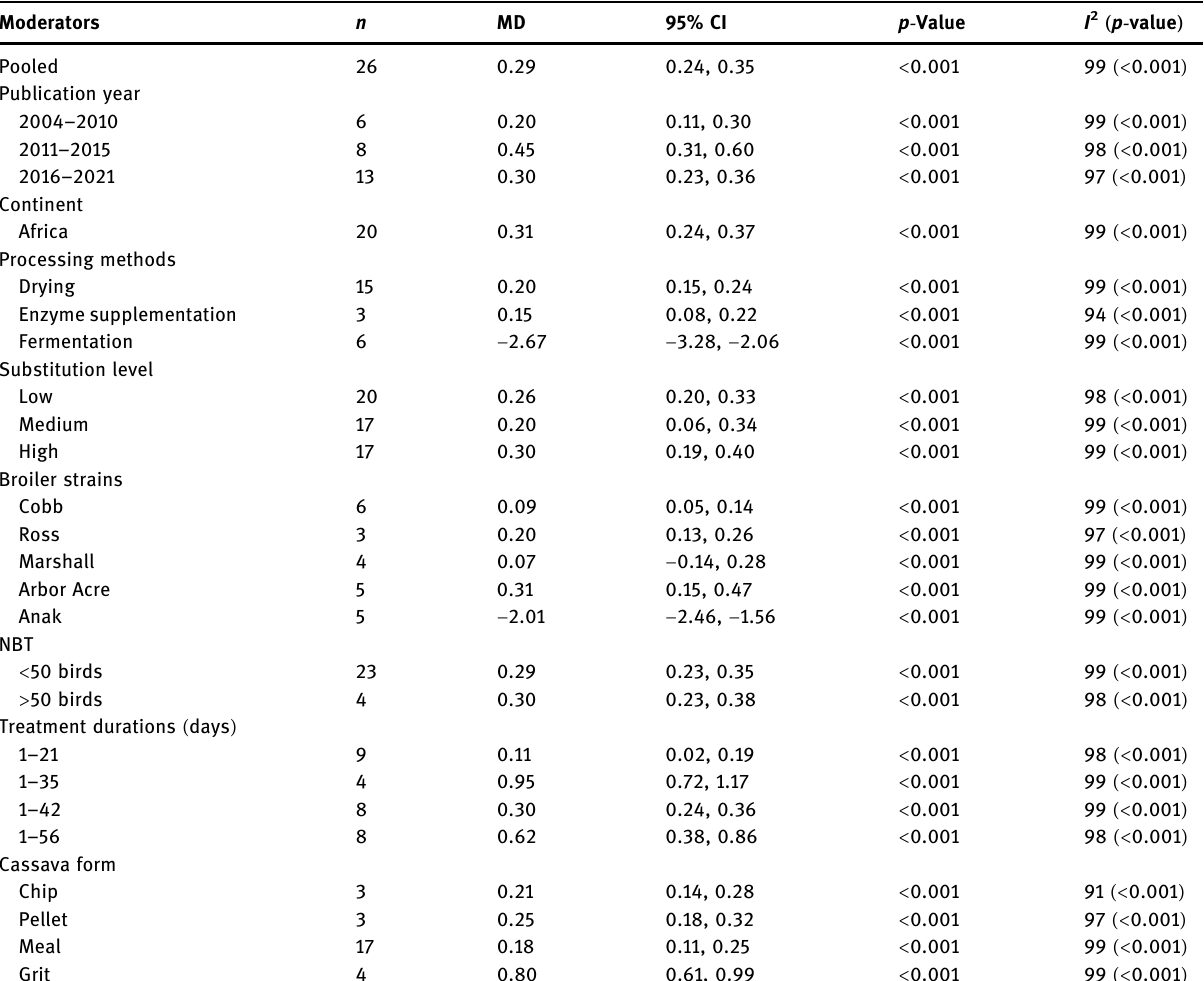
Table 5: E ff ect of cassava on FCE in broiler